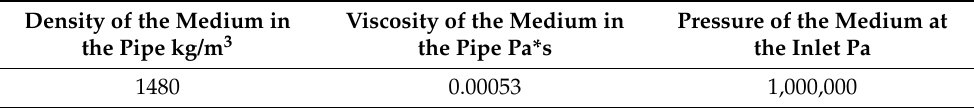
Table 3. Media parameters of the simulation model. Viscosity of the Medium in Pressure of the Medium at Density of the Medium in the Pipe Pa*s the Inlet Pa the Pipe kg/m 3 1480 0.00053 1,000,000